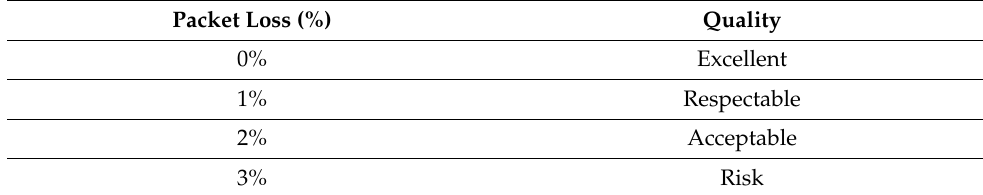
Table 2. Performance of the packet loss.